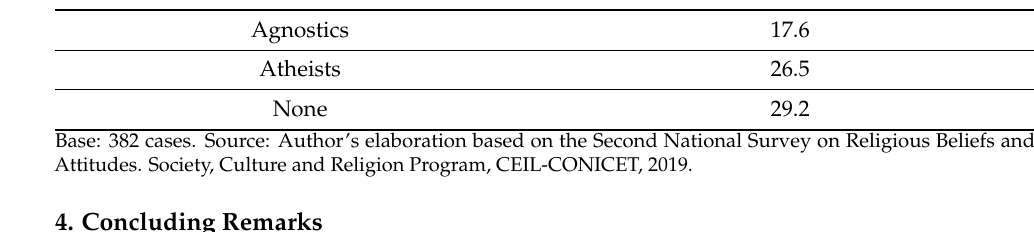
Table 6. Scale of ideological conservatism (in